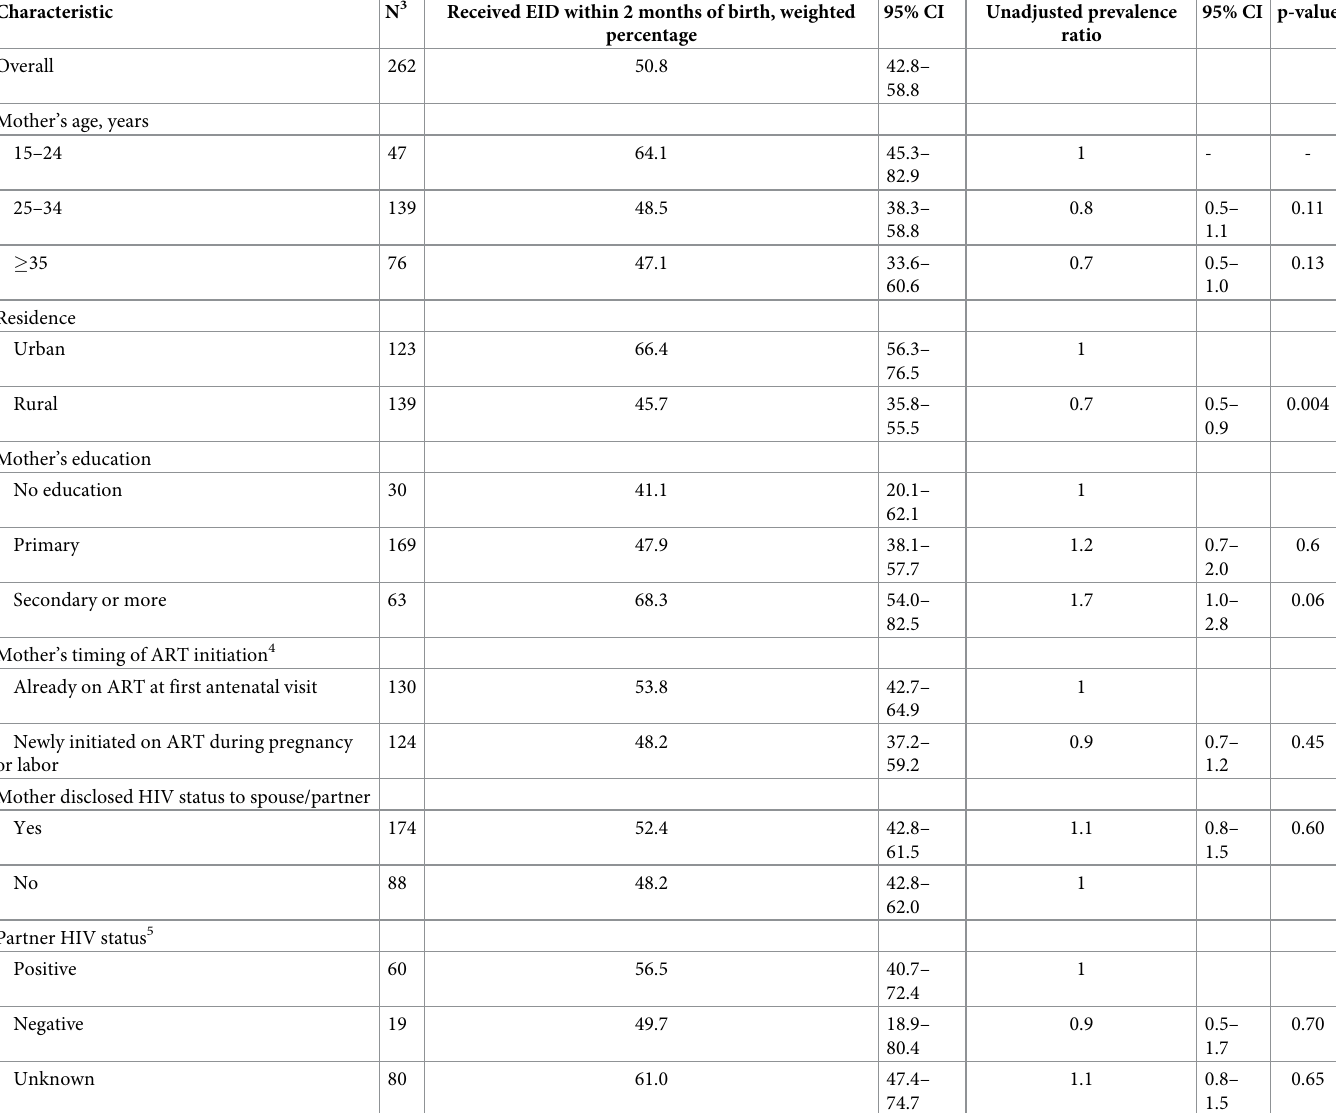
Table 4. Factors associated with receiving early infant diagnosis (EID) testing within 2 months of birth 1 among HIV-exposed children 2 included in the 2015–2016 Malawi Population-based HIV Impact Assessment (MPHIA) survey (N = 262).